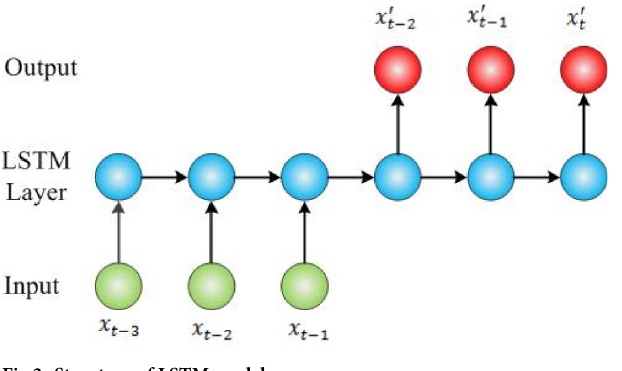
Fig 3. Structure of LSTM